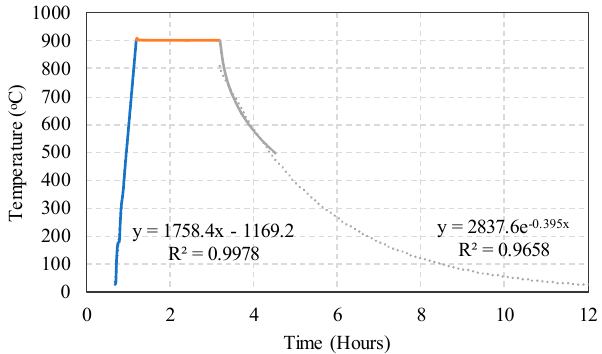
Figure 5. Temperature heating profile of muffle furnace.